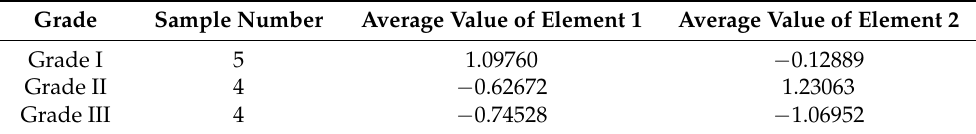
Table 17. Average values for two principal components of each